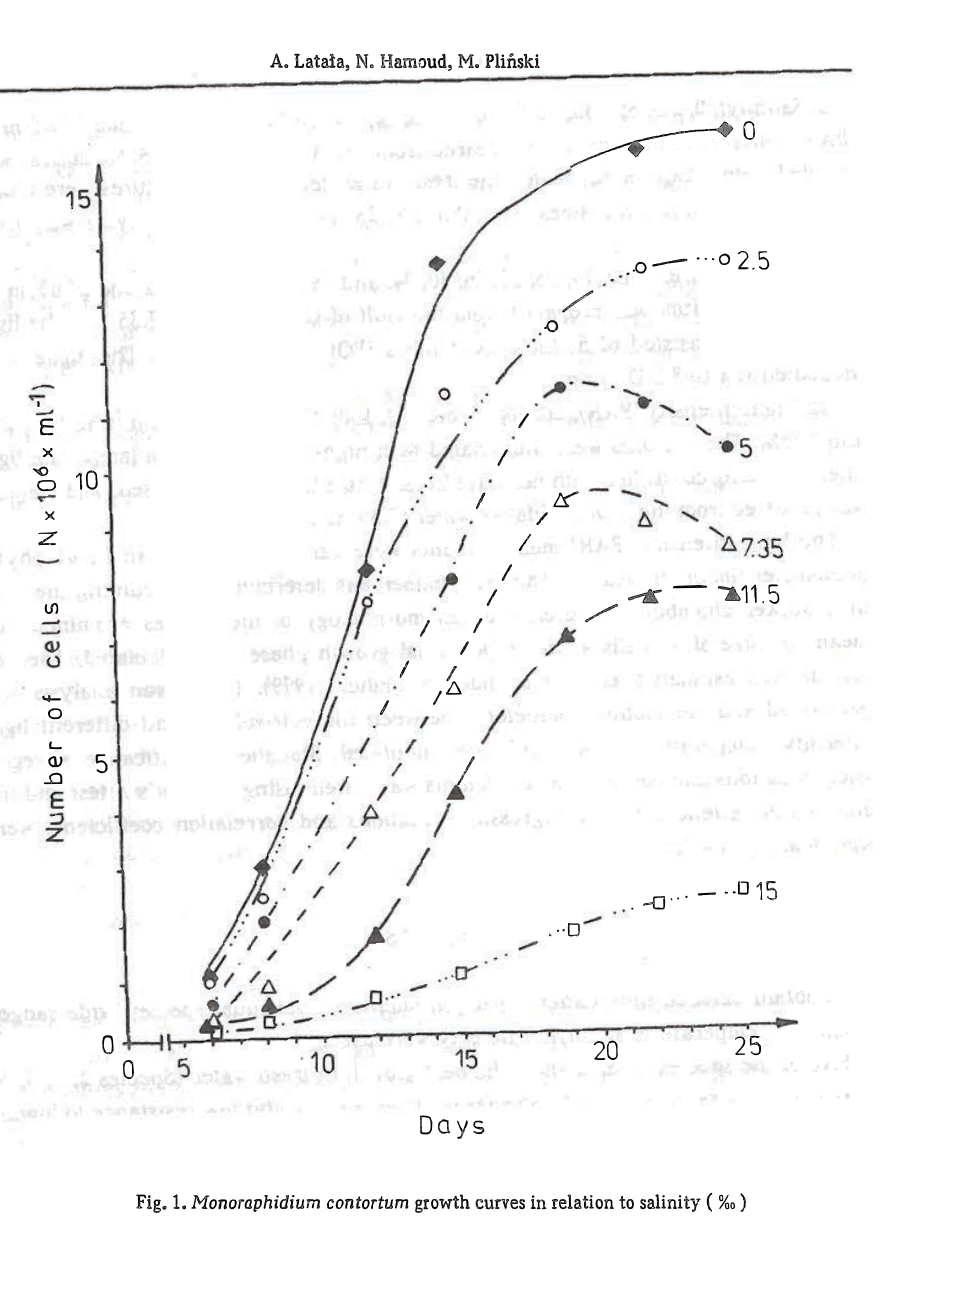
Figo L Monoraphidium contortum growth curves in relation to salinity ( %,